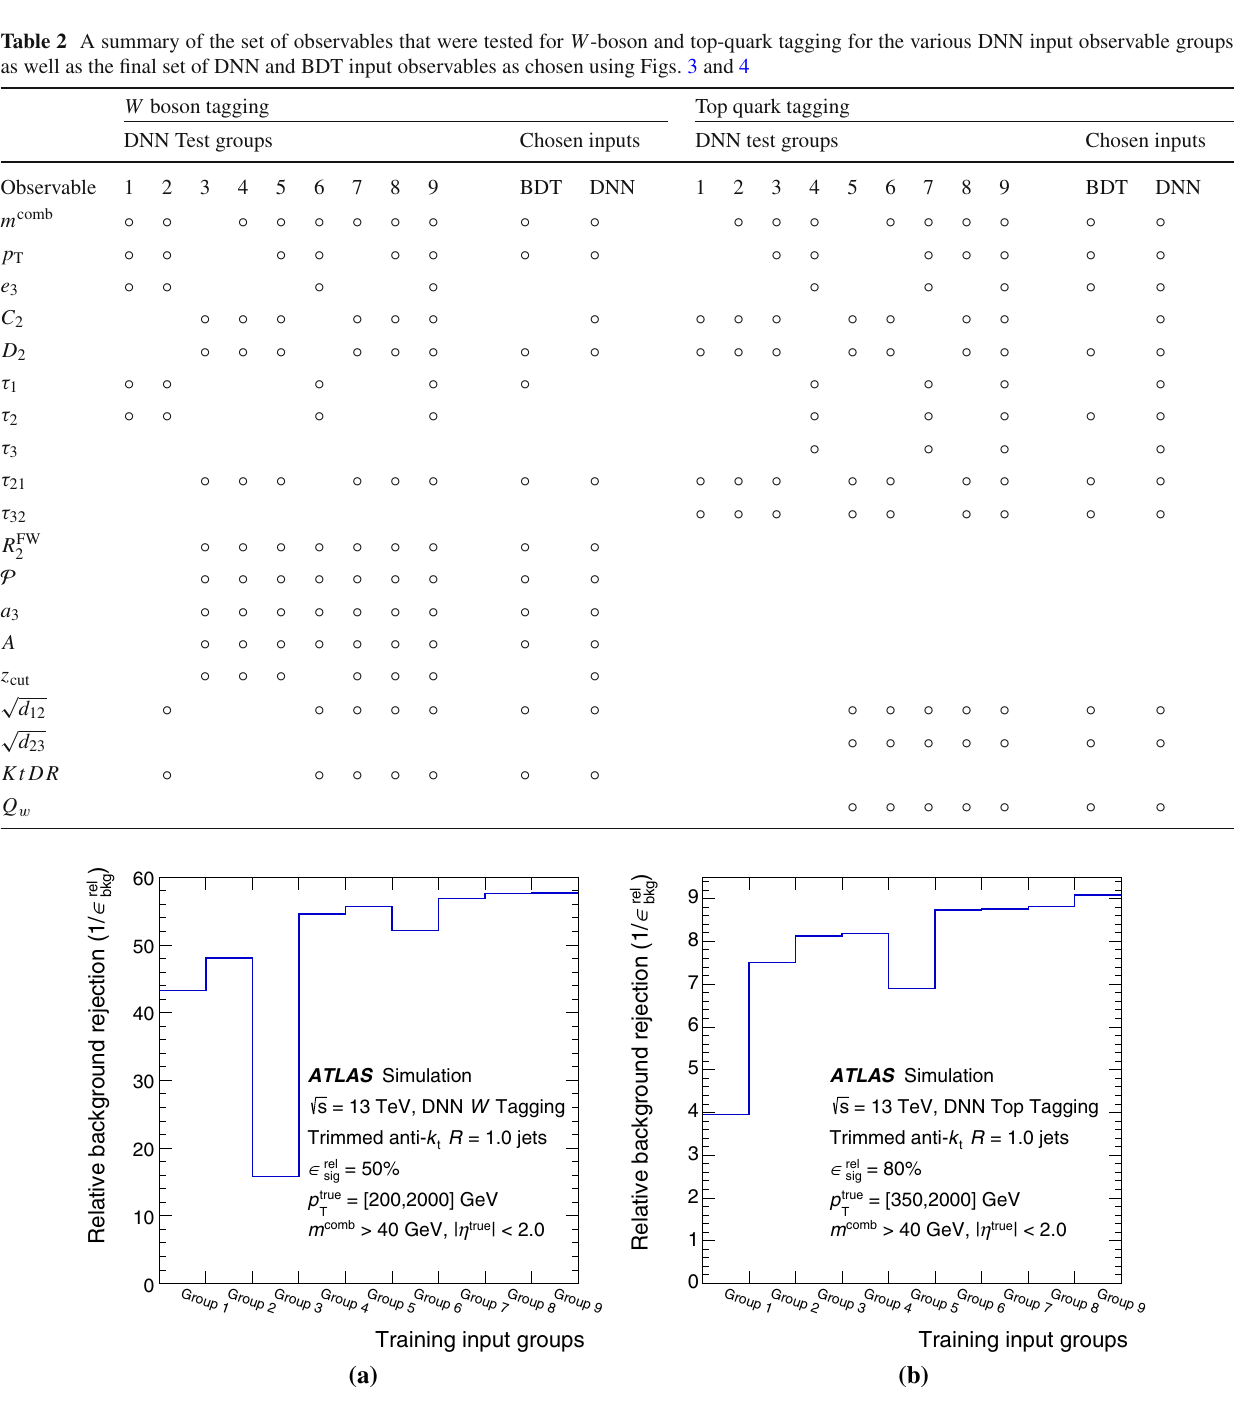
Fig. 4 Distributionsshowingthetrainingwithdifferentsetofvariables and relative improvement in performance for the DNN W -boson ( a ) and top-quark ( b ) taggers at the 50% and 80% relative signal efficiency working point, respectively. The grouping of observables was decided prior to training and discriminator performance evaluation. Only jets